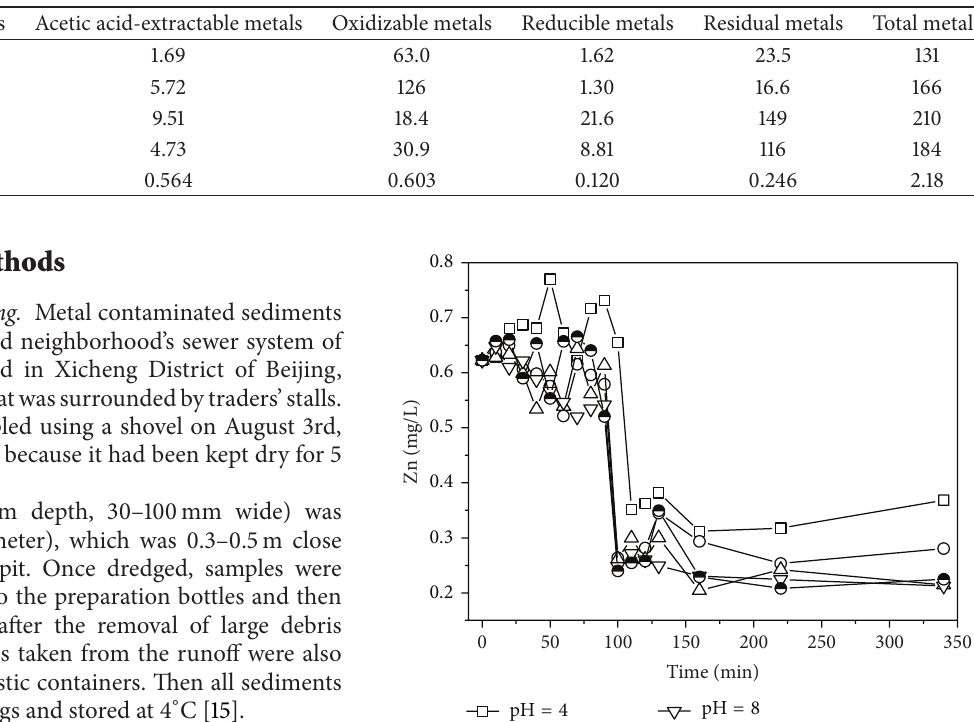
Table 1: Concentration of heavy metals (mg ⋅ Kg − 1 ) in test sediments.